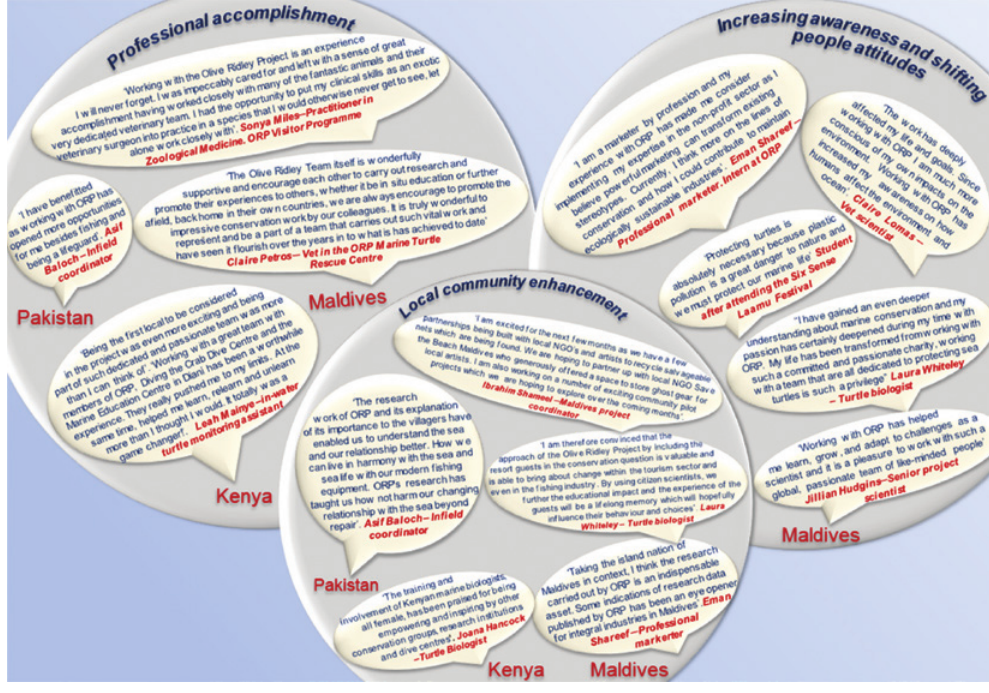
figure 3: a representation of testimonies provided by the oRP team and community members involved in charity activities (credit: